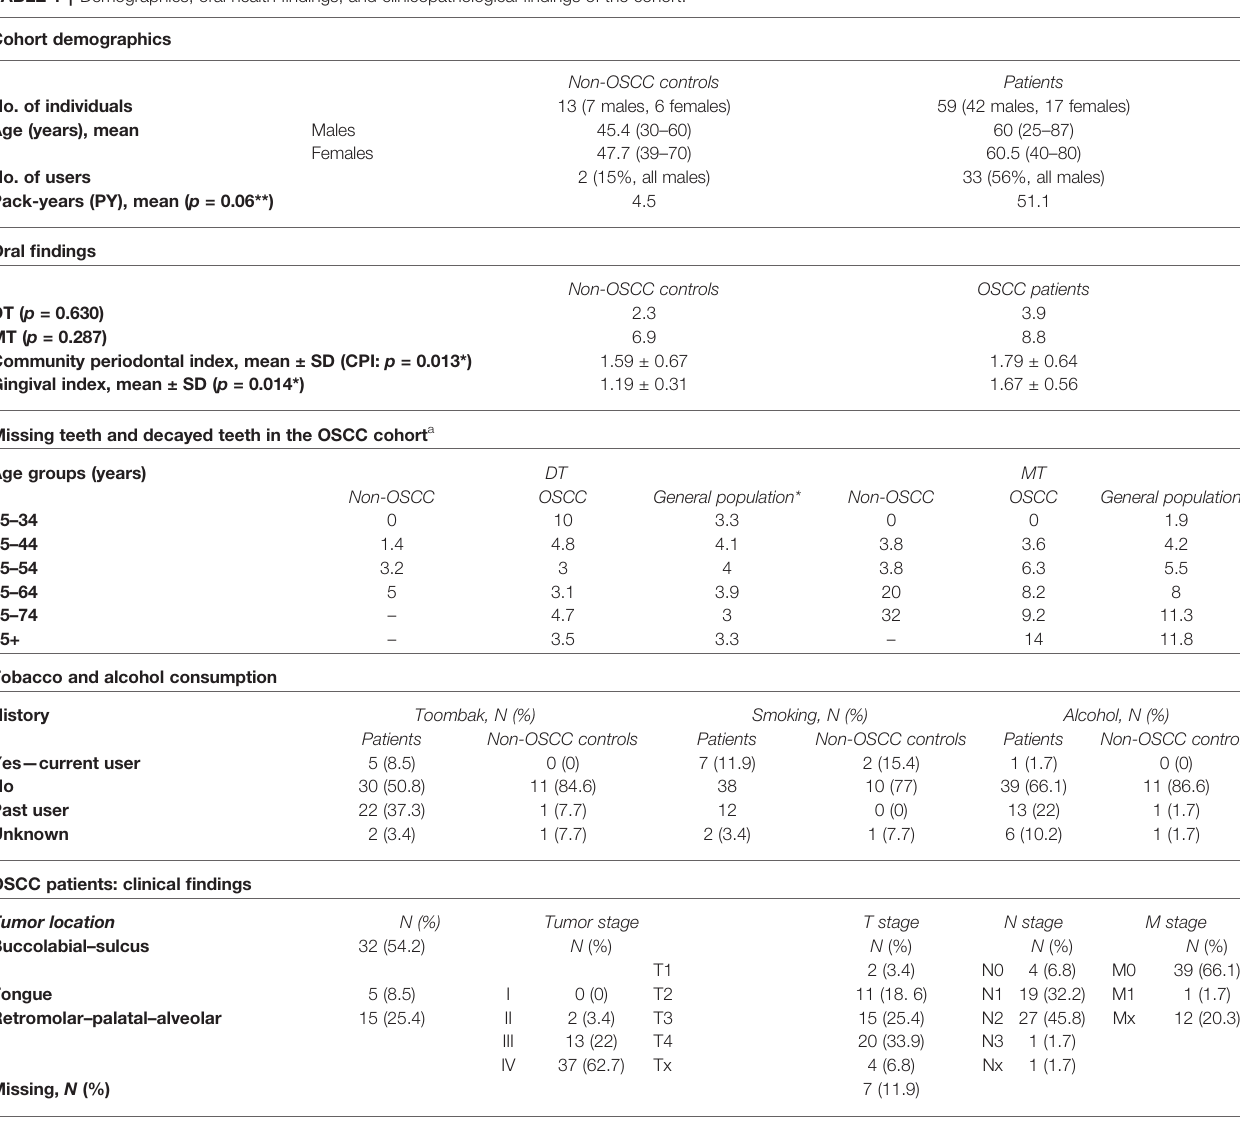
TABLE 1 | Demographics, oral health fi ndings, and clinicopathological fi ndings of the cohort. Cohort